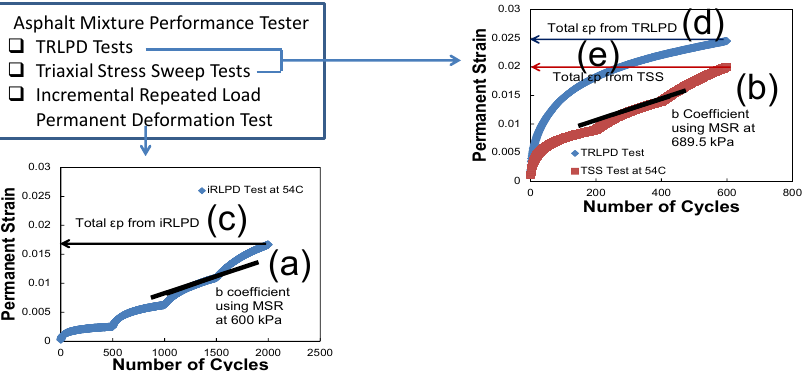
Figure 7. Ru tt ing index method without mechanistic analysis: (a): b coe ffi cient-MSR 600 kPa, (b): b Figure 7. Rutting index method without mechanistic analysis: (a): b coefficient-MSR 600 kPa, (b): b coe ffi cient-MSR at 689.5 kPa, total ερ from (c): iRLPD, (d): TLRPD; (e): TSS. coefficient-MSR at 689.5 kPa, total ερ from (c): iRLPD, (d): TLRPD; (e):